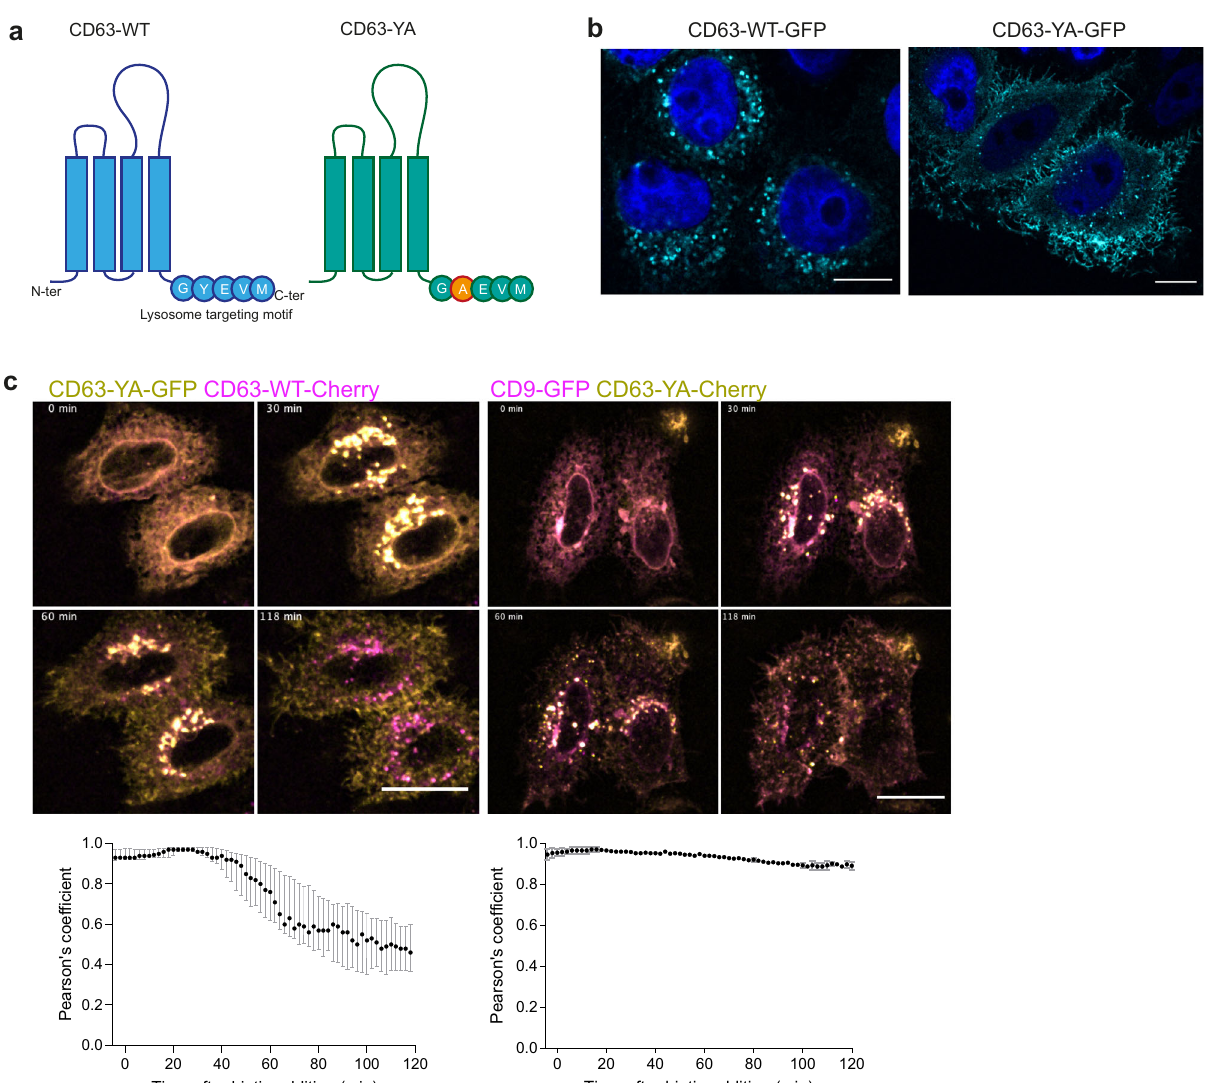
Fig. 3 The mutant CD63-YA displays different traf fi cking from CD63-WT and similar traf fi cking as CD9. a Scheme of the structure and C-terminal sequences of CD63-WT and the mutant CD63-YA. b Immuno fl uorescence of HeLa cells transfected with the RUSH CD63-eGFP or CD63-YA-eGFP plasmids at steady state. Scale bar 10 μ m. This experiment was performed once. c Micrographs of HeLa cells co-transfected with CD63-YA-eGFP and CD63-WT- mCherry or CD9-eGFP and CD63-YA-mCherry , and median ± range of the Pearson ’ s co-localization coef fi cient over time between eGFP and mCherry. Biotin was added at T = 0. Z -projection of 11 planes. Scale bar 5 μ m. CD63/CD63-YA: 3 independent experiments n = 51 cells, CD9/CD63-YA: 2